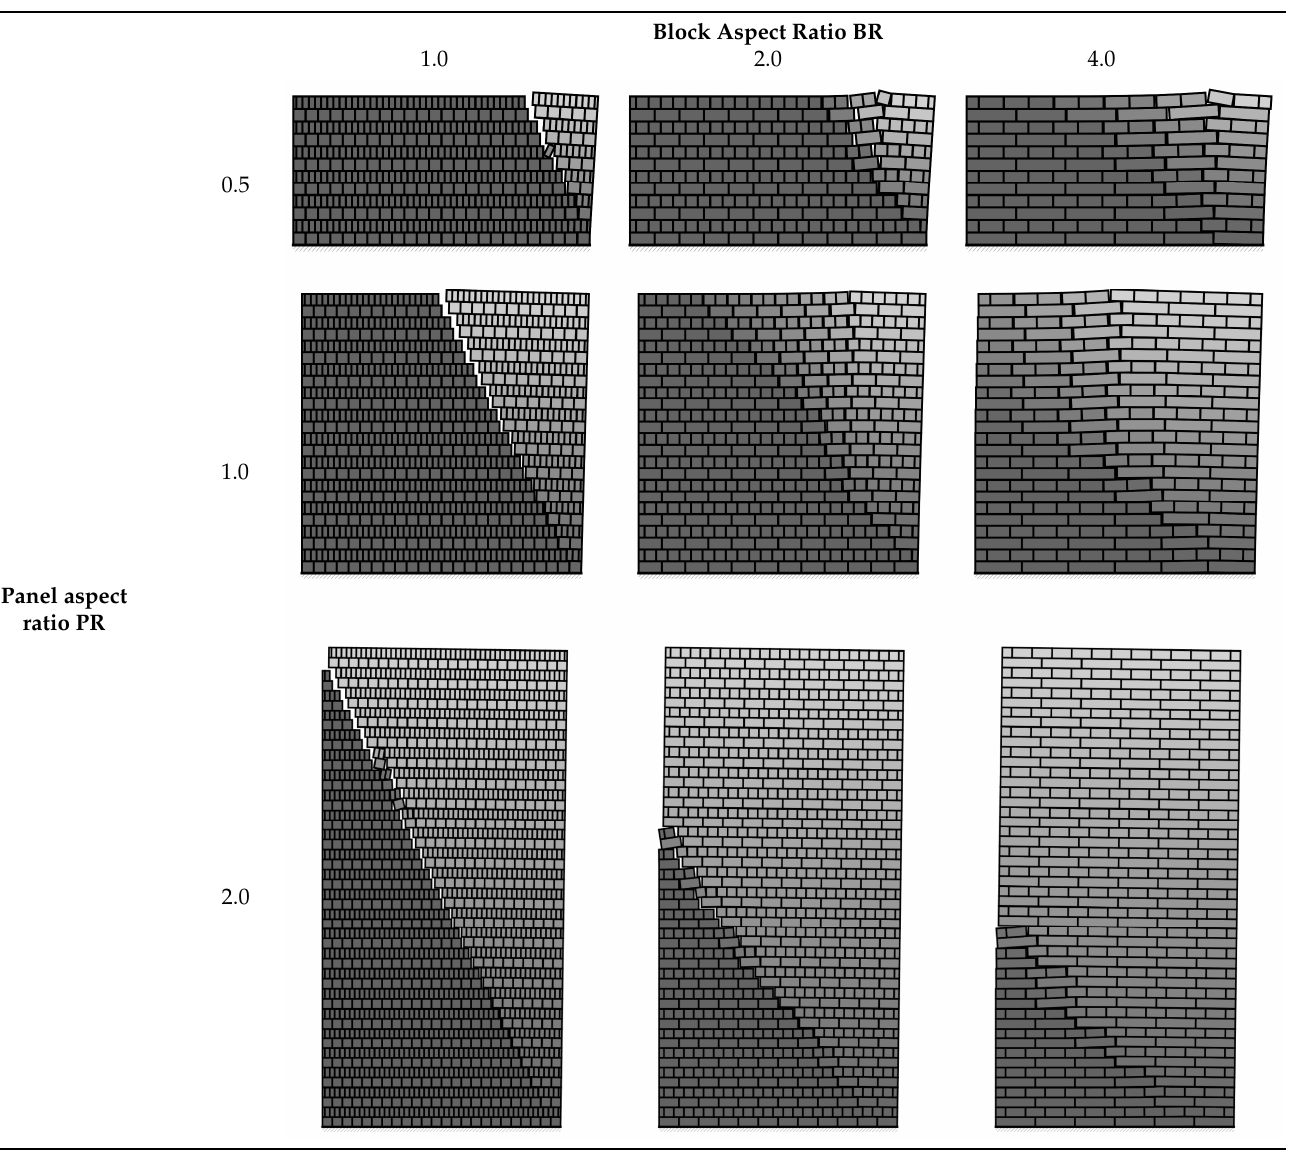
Table A9. Failure Mechanisms for English Bond with µ = 0.80.